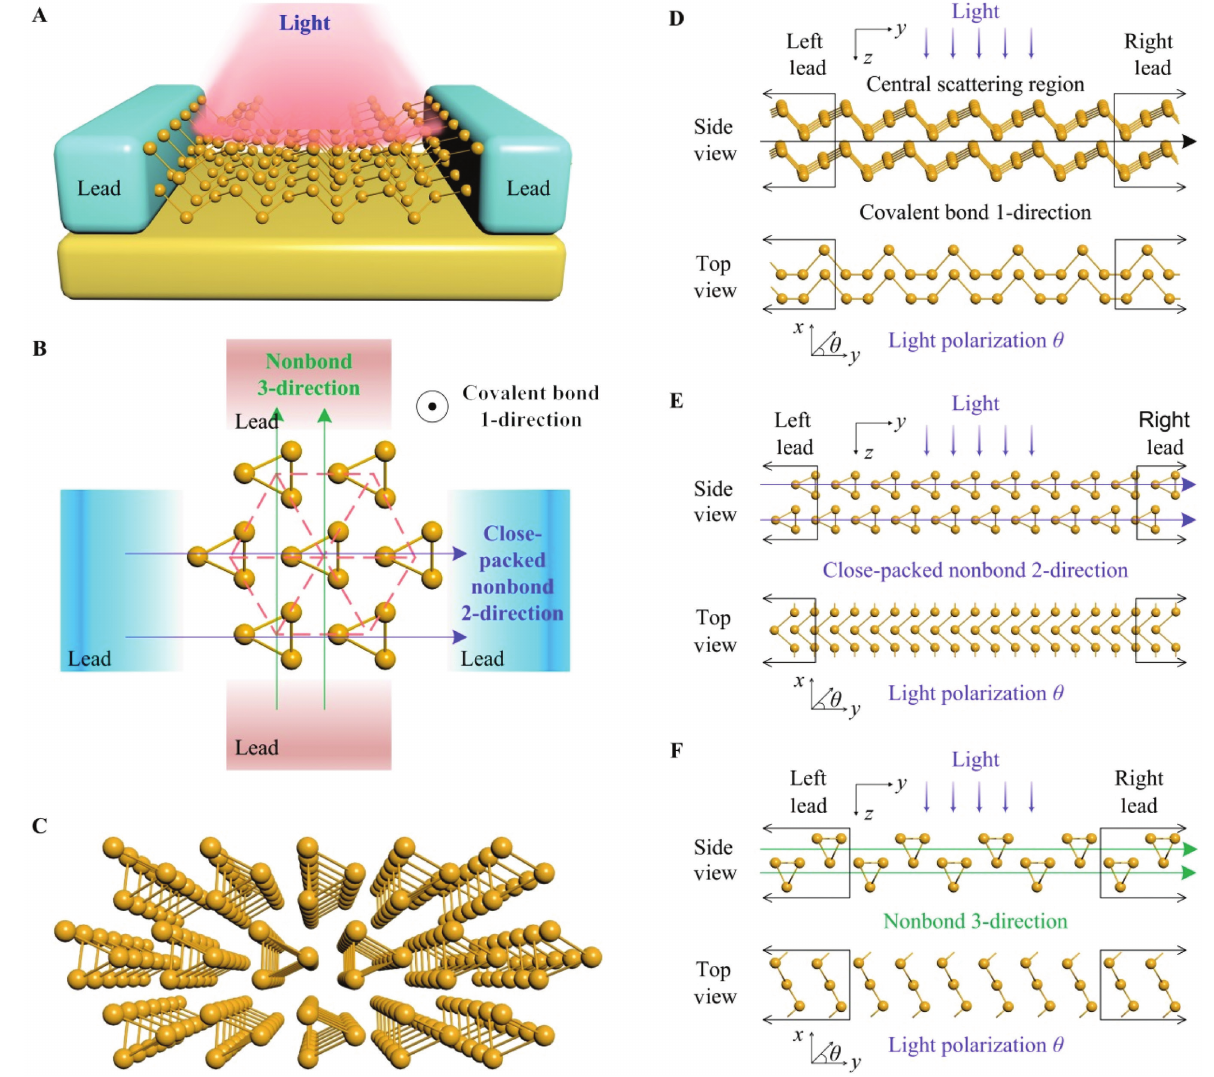
Figure 1: Illustration of bilayer tellurene photodetector. (A) The model of the bilayer tellurene photodetector. (B) The diagram of the helical chain of tellurium along the 1-direction and the definition of three transport directions. (C) The lattice structure of bulk tellurium. The top and side views of bilayer tellurene photodetector in the (D) covalent bonded 1-, (E) close-packed nonbond 2-, and (F) nonbond 3-directions. The left and right electrodes are enclosed with black arrow, and the rest area is the central scattering region that the incident light illuminates. The polarization angle θ is the angle of light polarized orientation with respect to its transport